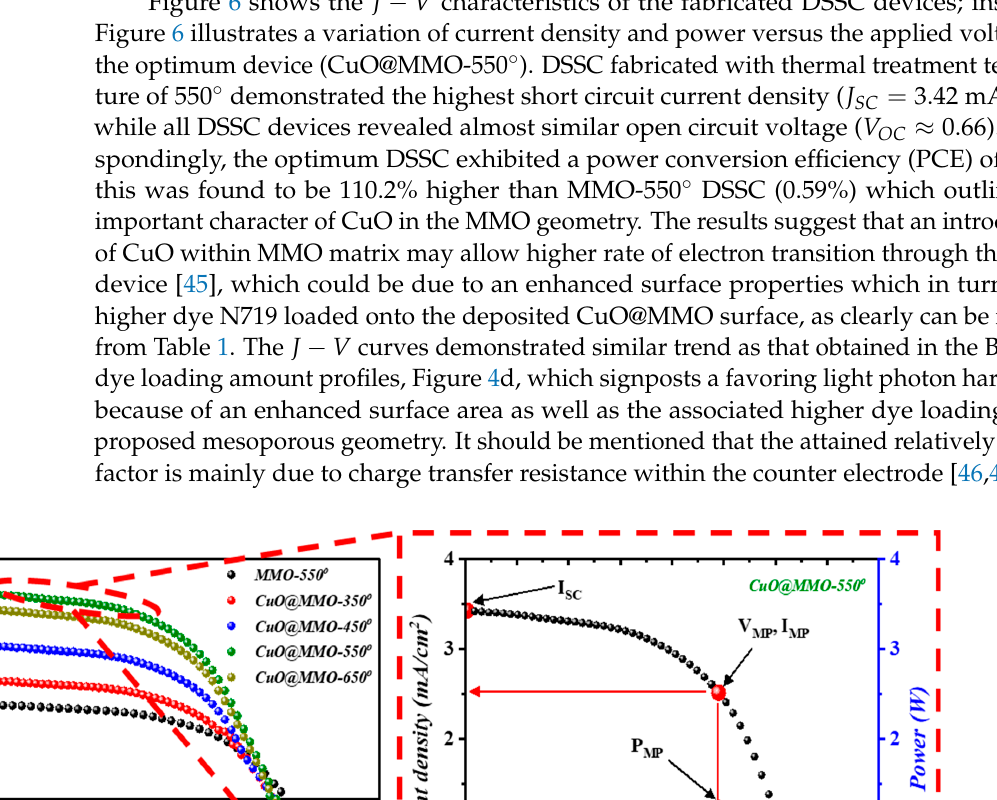
Figure 5. The proposed geometry band diagram [29,43,44].